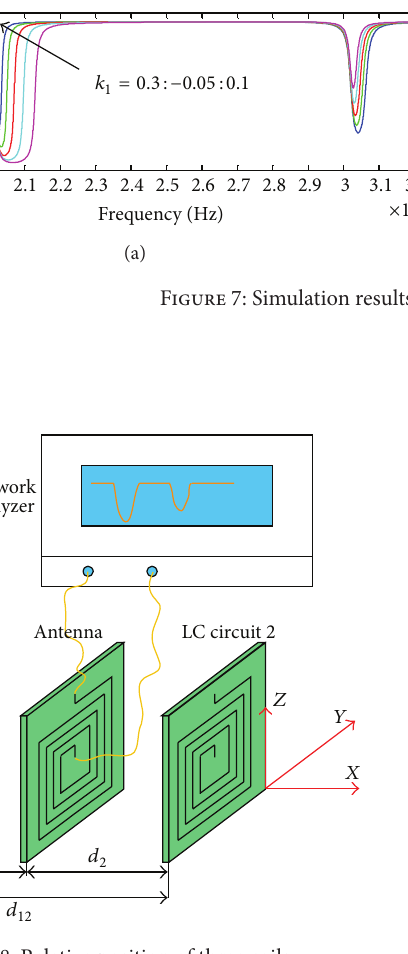
Figure 8: Relative position of three